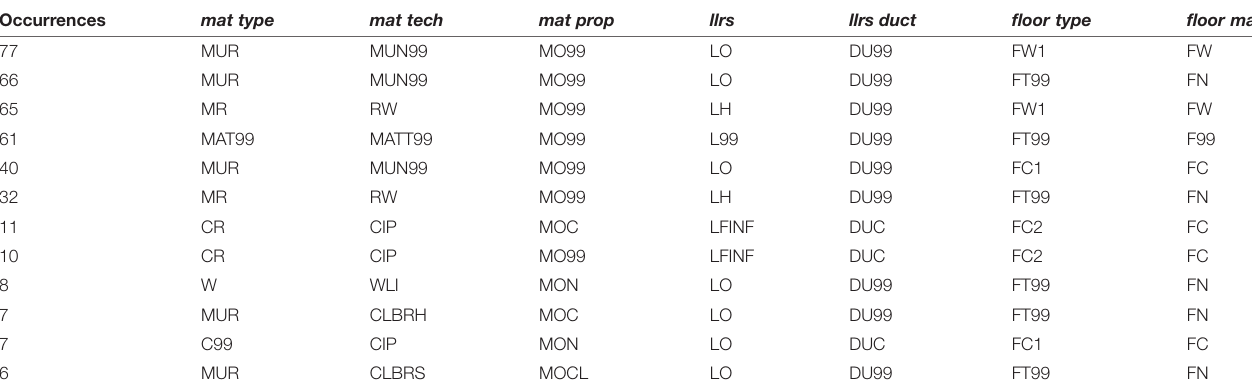
TABLE 3 | Distinct combinations of observed attributes with more than 5 occurrences, in descending